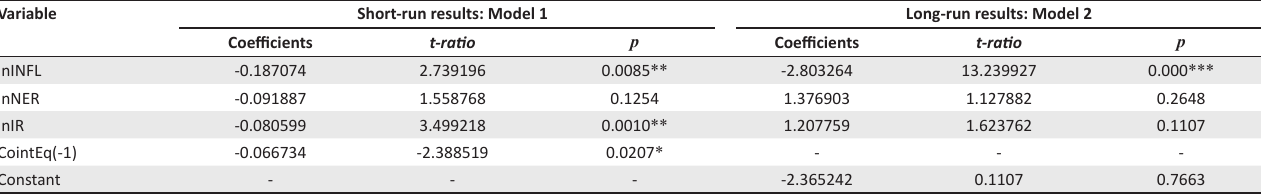
TABLE 3: Results of short and long run without structural break. Variable Short-run results: Model